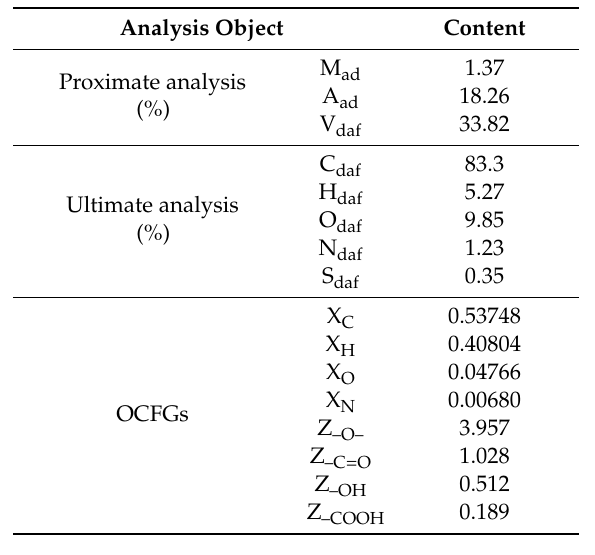
Table 3. Basic properties of the demineralized HNC and content of oxygen-containing functional groups